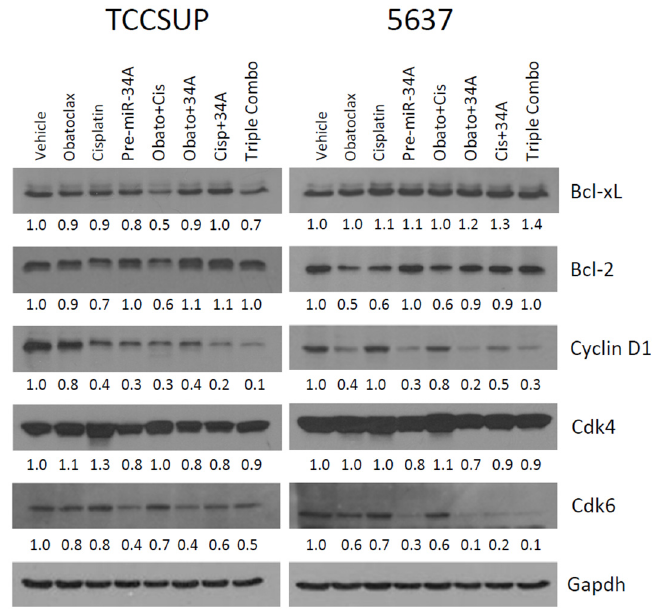
Figure 4. Combining Obatoclax with cisplatin and/or pre-miR-34a can impact expression levels of Bcl-xL and Bcl-2 as well as expression levels of cyclin D1 and cdk4/6. In TCCSuP cells, the Obatoclax + cisplatin combination treatment was the most effective treatment with regards to its ability to decrease the expression levels of Bcl-xl and Bcl-2. In 5637 cells, this combination treatment caused a similar impact on these molecules compared to treatment with Obatoclax as a single agent. Combining pre-miR-34a with Obatoclax and/or cisplatin caused increased levels of Bcl-2 expression both TCCSuP and 5637 cells, and increased levels of Bcl-xL in 5637 cells compared to treatment with Obatoclax and/or cisplatin. Treatment with Obatoclax as a single agent or in combination with cisplatin reduced the expression of cyclin D1 and Cdk6 in both cell lines. Treatment with pre-miR-34a also caused the reduced expression of cyclin D1 and Cdk6; however, it caused increased Bcl-2 expression and negated the effect on Obatoclax on Bcl-2 expression in the combination treatments in both cell lines. Unlike the other treatments, pre-miR-34a was also able to reduce Cdk4 expression levels at the treatment doses used for this experiment (Obatoclax; 25, 60, and 40 nM, respectively, in T24, TCCSuP, and 5637, cisplatin; 5 µ M, pre-miR-34a; 50 nm). (Veh = vehicle control, Cis = cisplatin, 34a = pre-miR-34a, Obato = Obatoclax, triple combo = Obatoclax + cisplatin + pre-miR-34a).